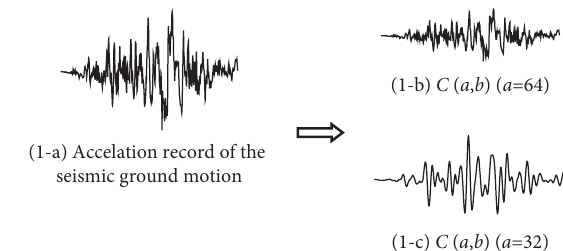
Figure 1: Schematic diagram of C ( a, b ) of seismic ground motion.